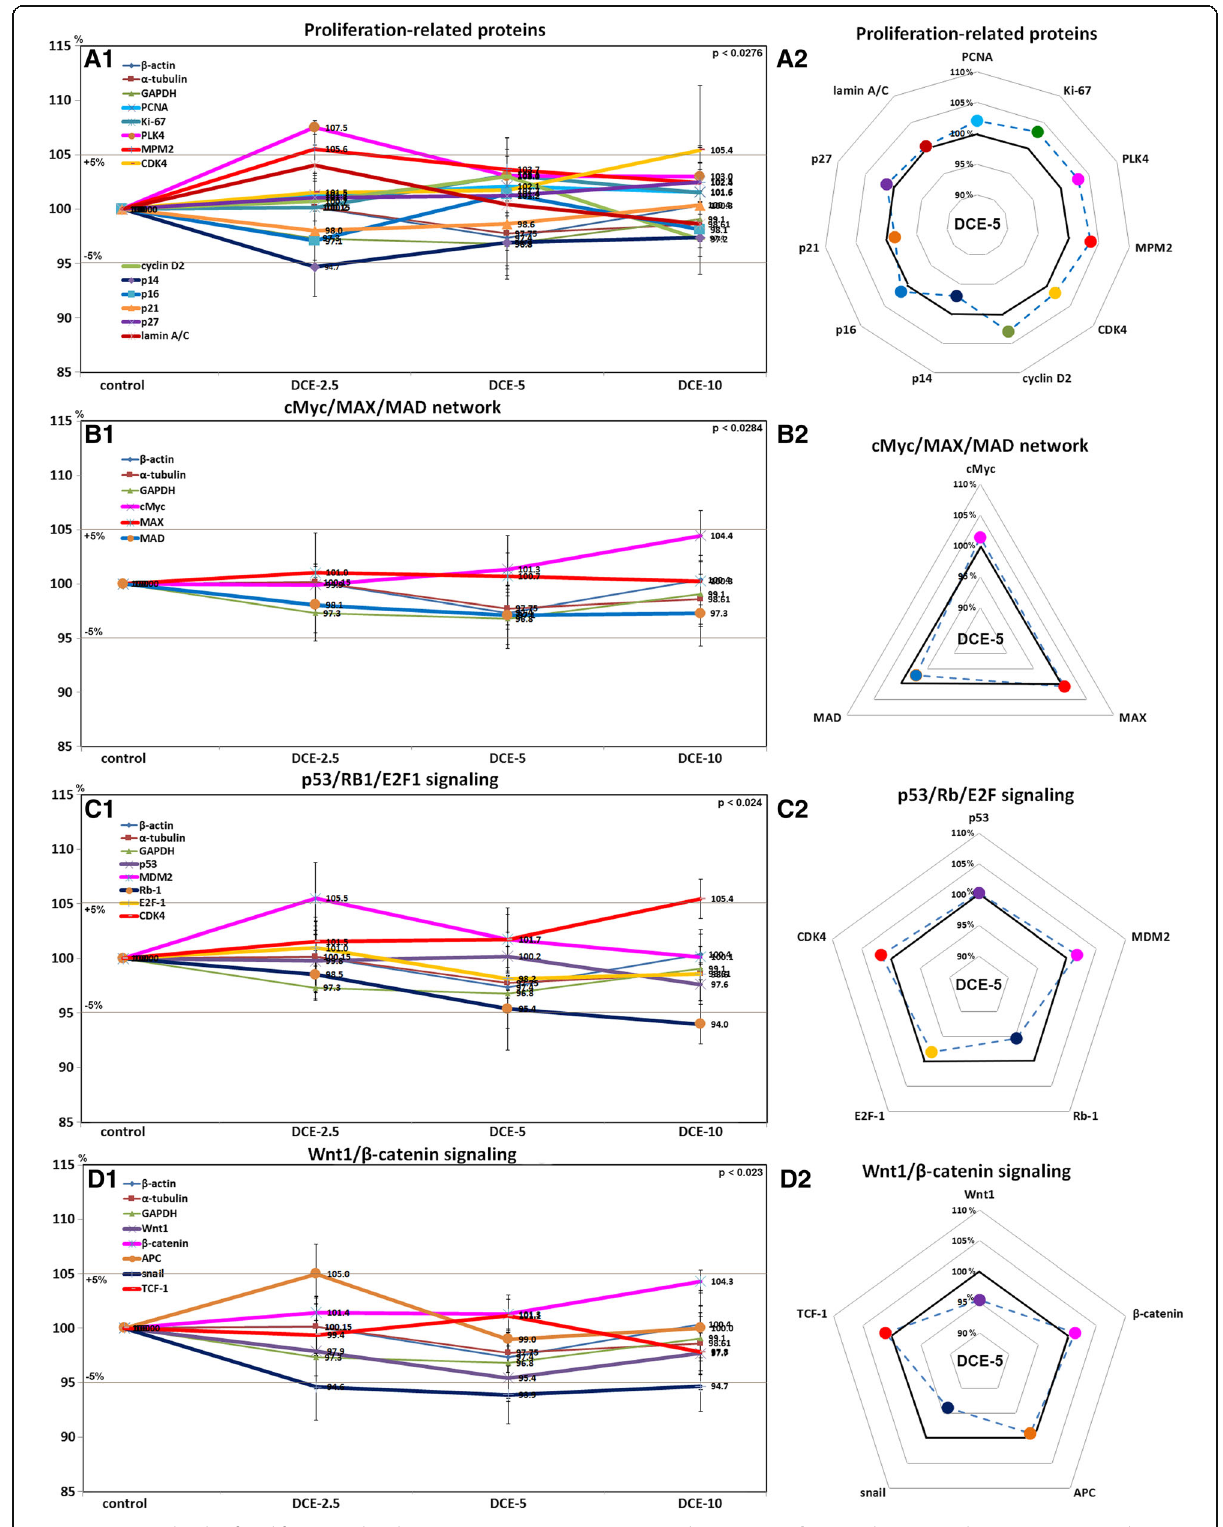
Fig. 3 Expression levels of proliferation-related proteins ( a ), cMyc/MAX/MAD signaling proteins ( b ), p53/Rb/E2F signaling proteins ( c ), and Wnt1/ β -catenin signaling proteins ( d ) after DCE treatment in mouse livers as determined by IP-HPLC. Major protein expression pattern induced by DCE- 5 was found in the radial graphs of A2, B2, C2, and